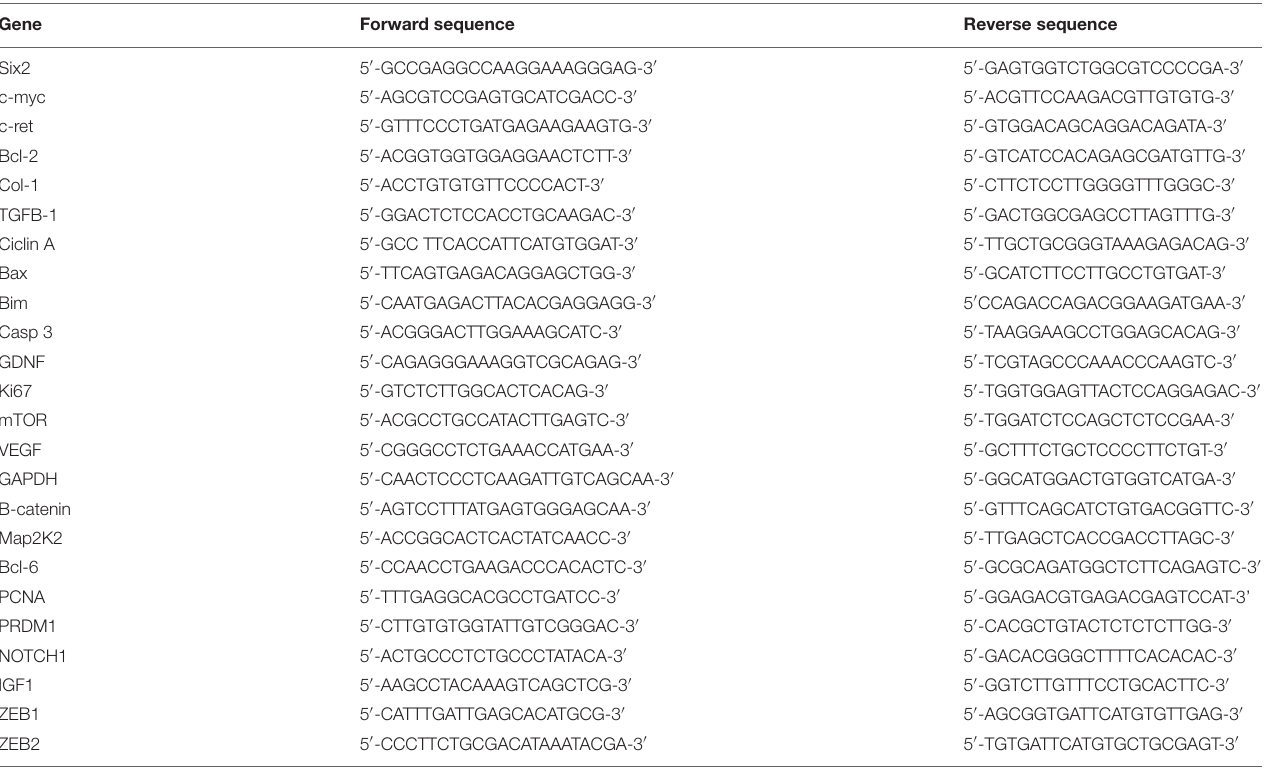
TABLE 2 | Sequence of the primers used for RT-qPCR, designed by the company IDT. Gene Forward sequence Reverse